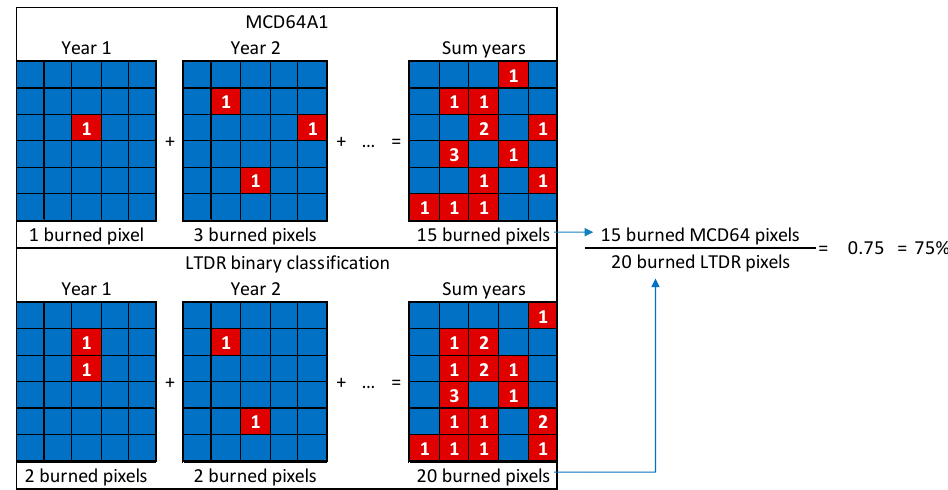
Figure 10. Calculation of the percentage of Burned Area for the 0.25° cell. The MCD64A1 had 15 pixels classified as burned after aggregating all years during the time series. The LTDR product had 20 pixels classified as burned for the same period. Therefore, each LTDR pixel for this cell was considered to be 75% burned.